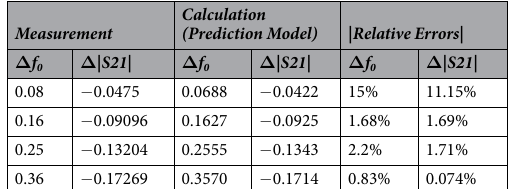
Table 2. Measured, calculated variations and their relative errors. The relative errors refer to the differences between calculation and measurement divided by calculated